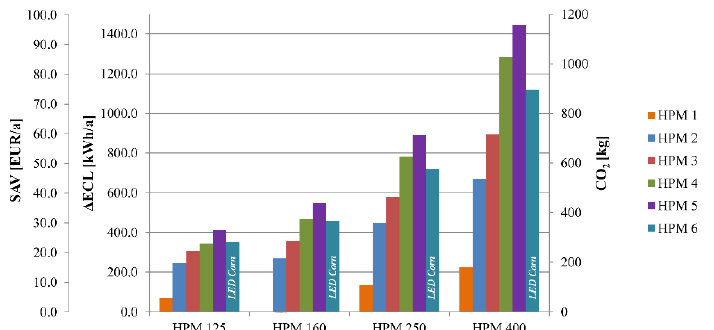
Figure 3. Annual energy savings, financial savings and reductions in CO 2 emissions for different energy efficiency improvement scenarios—HPM lamps.